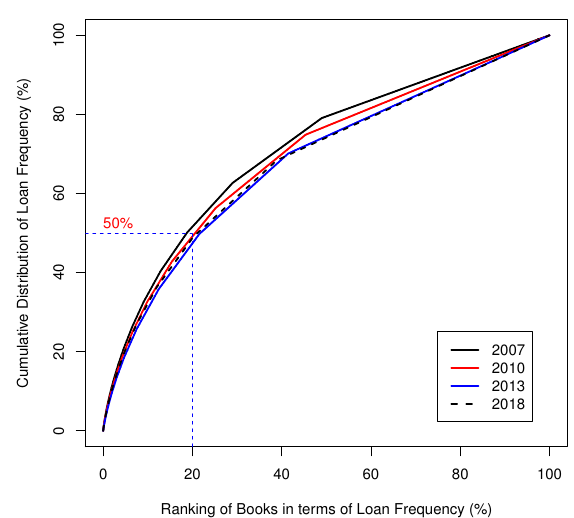
Figure 2. Cumulative distribution of one-year loan frequency arranged in descending order, where book loan data of years 2007, 2010, 2013, and 2018 are considered. The 20/50 loan rule is observed.